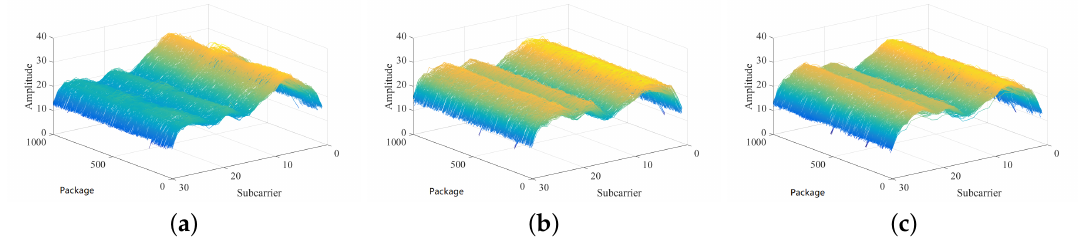
Figure 1. The amplitude distribution of different positions at 1000 time points. ( a ) Position 6; ( b ) Position 14; ( c ) Position